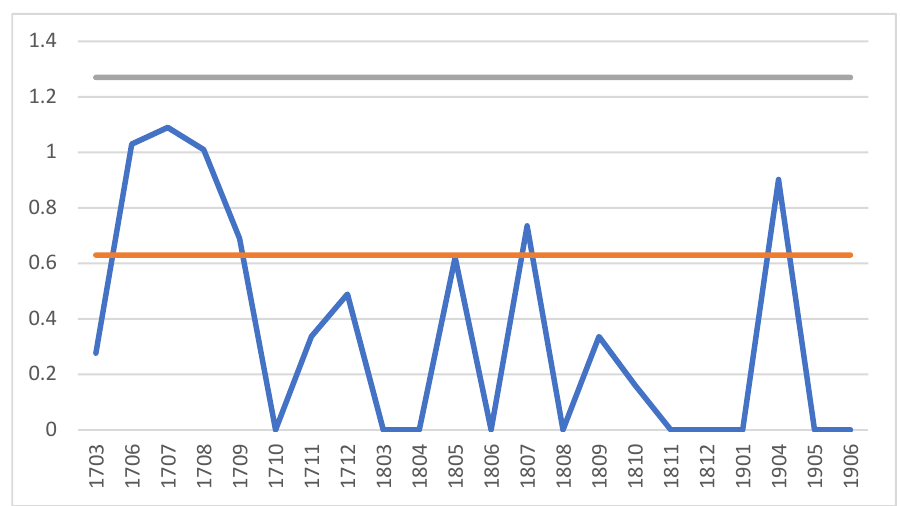
Figure 11 represents the keyword frequency of the antecedent “parking”. The gray line represents the upper cut-off value, and the orange line represents the lower cut-off value. It indicates that the keyword “parking” belongs to the upper range (0.63–1.27) in June to September 2017, July